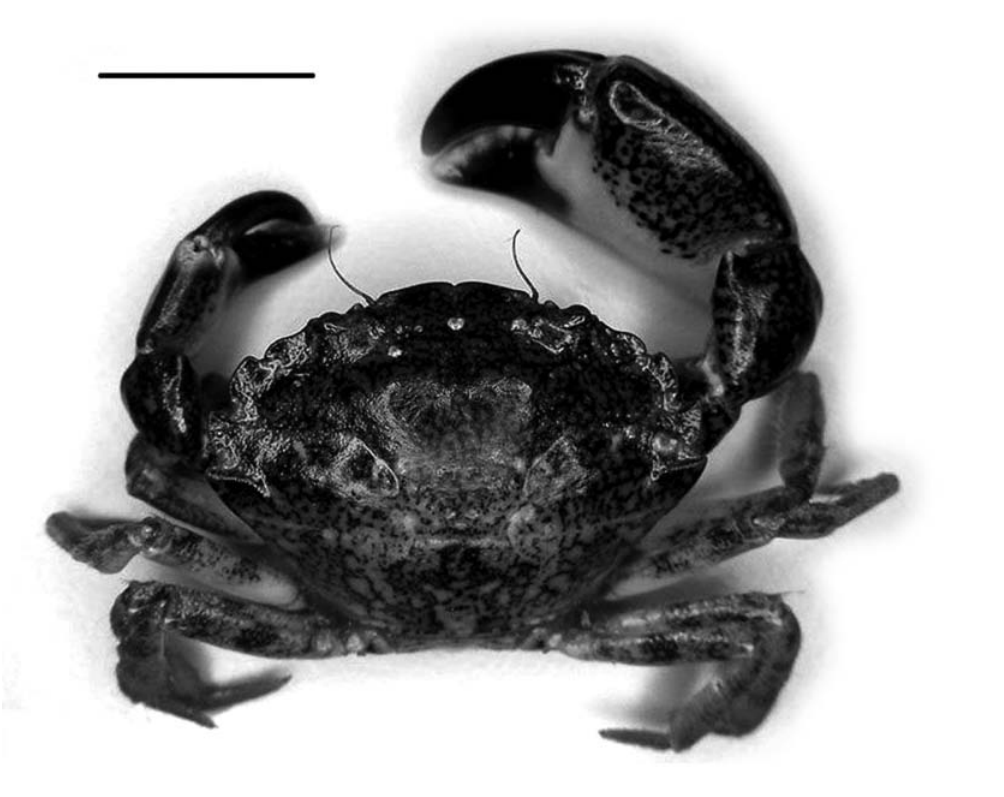
Fig . 2. – Dyspanopeus sayi . Adult specimen from Alfacs Bay (male; ICMD_20110201_01). Scale bar 10 mm.